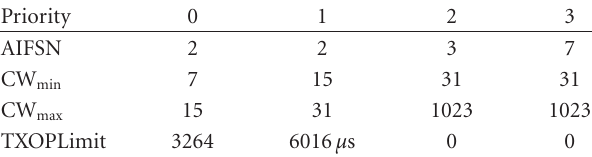
Table 3: Default EDCA parameters.